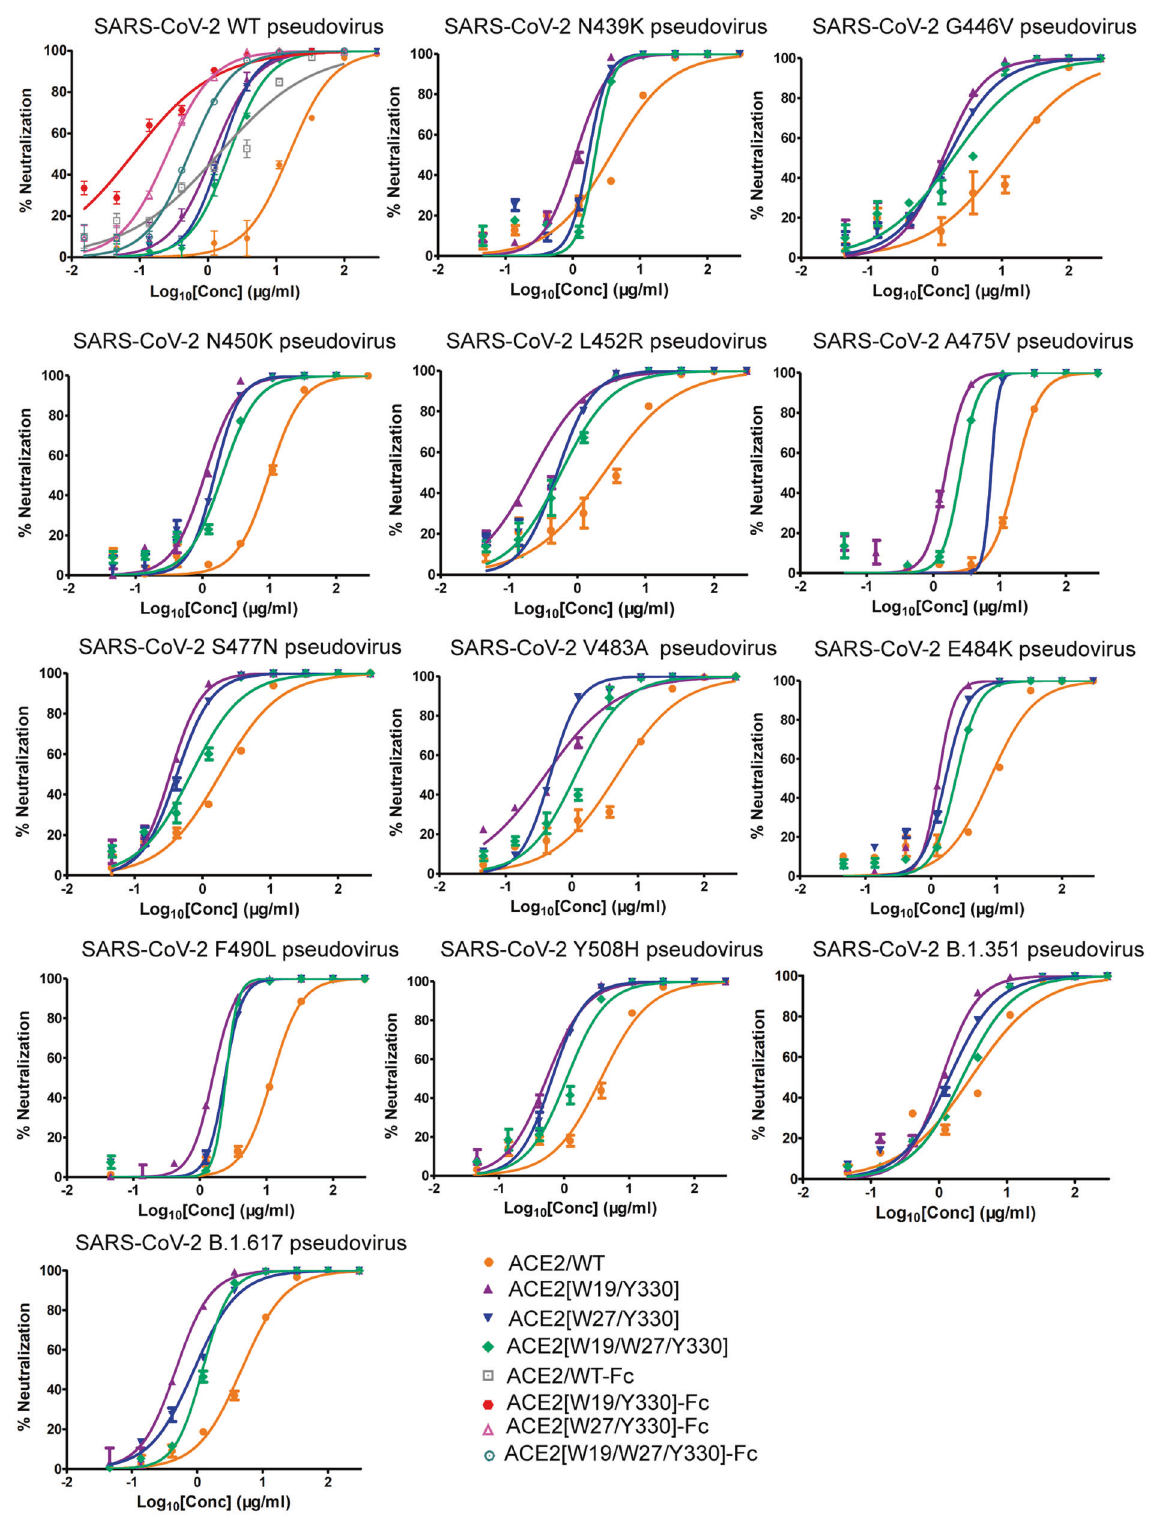
Fig. 5 Increased inhibitory ef fi cacy of the indicated ACE2 mutants in blocking virus entry of SARS-CoV-2. The luciferase-incorporated SARS- CoV-2 pseudoviruses (wild-type and antibody-resistant) are pre-incubated with the indicated ACE2 proteins (wild-type and mutants) for 1 h at 37 °C and then used to infect the human ACE2-transfecting 293T cells. Luciferase activities in target are measured. Each point represents the mean ± SD from triplicate experiments